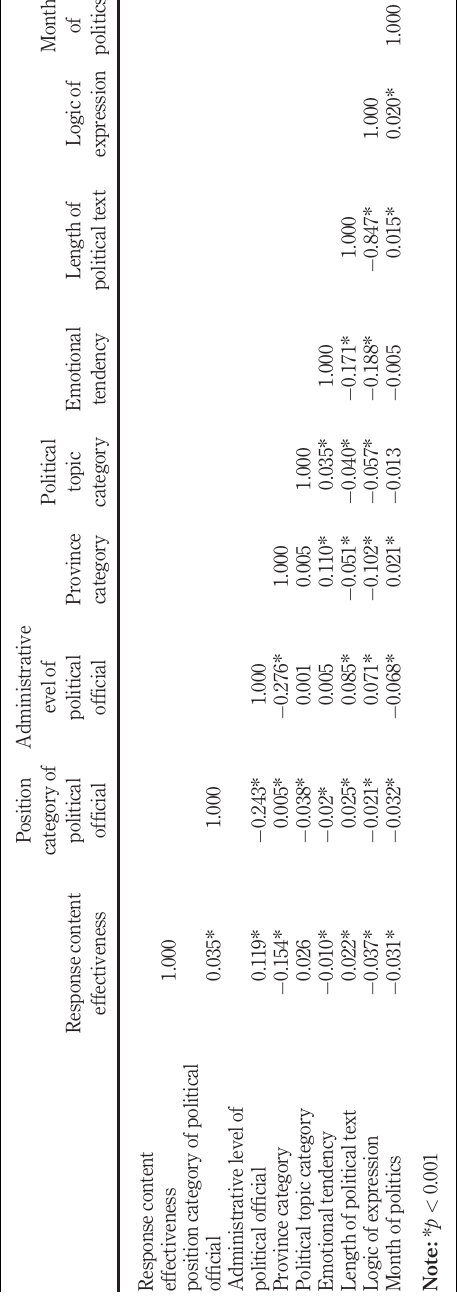
Table 4. Correlation analysis of factors